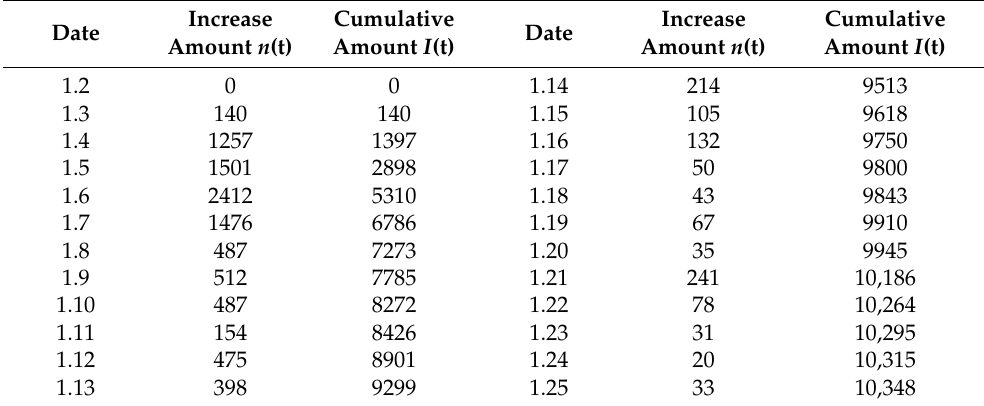
Table 2. Statistics on the spread of Microblog public opinion about Event